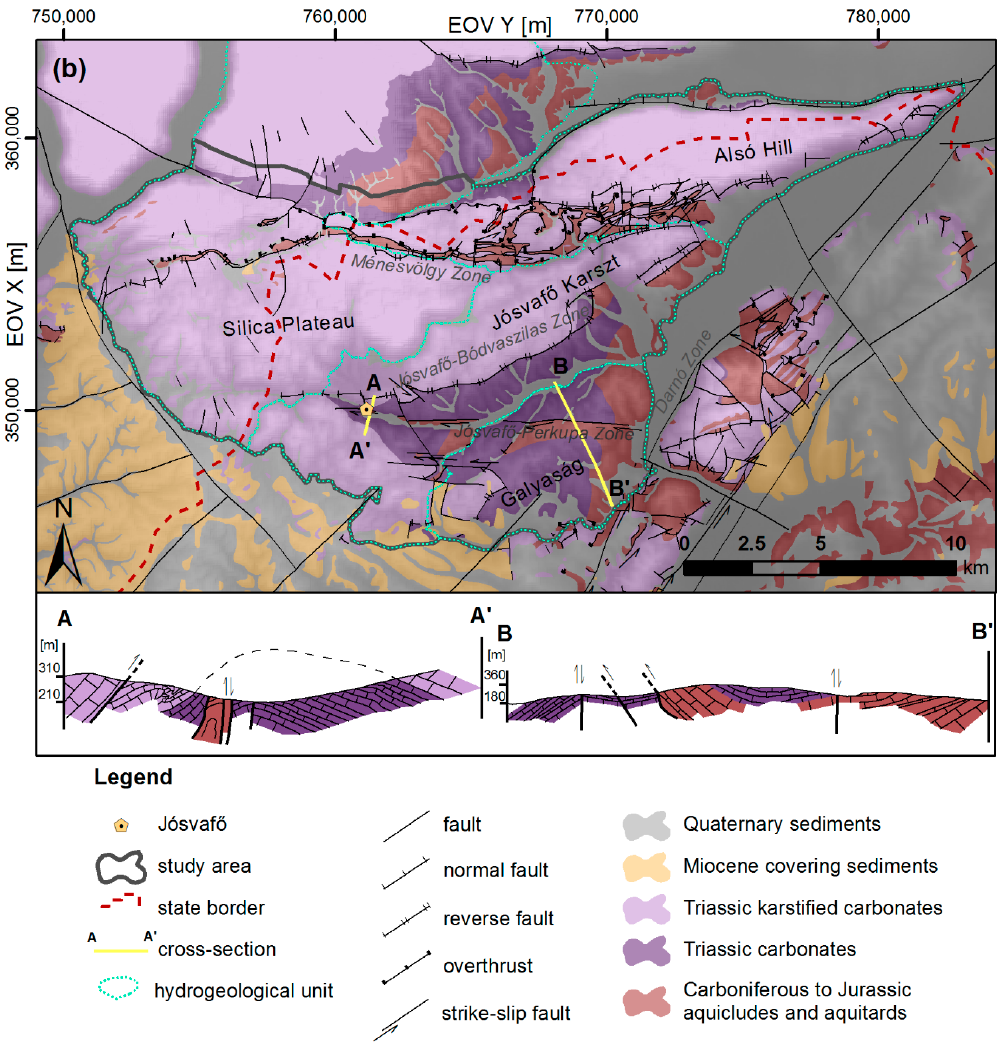
Figure 2. ( a ) Location and topography of the study area ( b ) Geological settings of the study area (based on map of Szentpétery and Less [45] , Sásdi [47] and cross-sections of Hips [46] ). Coordinates refer to EOV, the Hungarian National Grid, a transverse Mercator projection, in which the positive X direction indicates north and the positive Y direction indicates east.